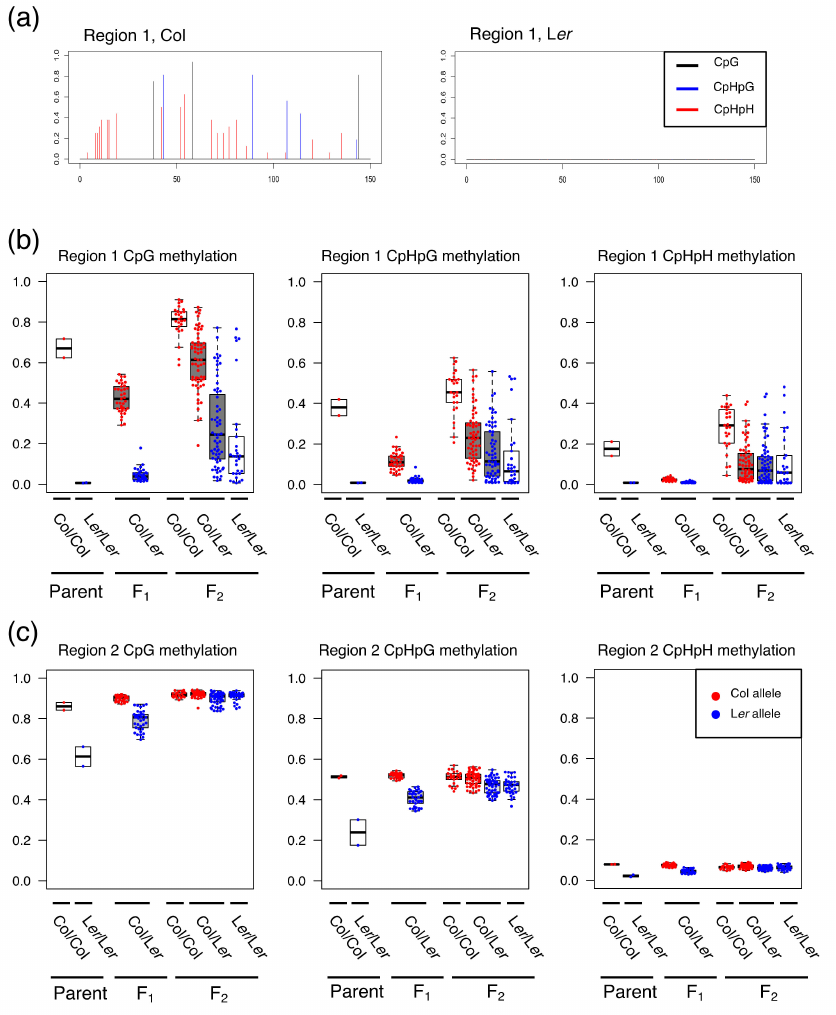
Figure 1. Level of DNA methylations in parents, F 1 , and F 2 . ( a ) Bar plots of DNA methylation level of Col and L er alleles in region 1; ( b , c ) The DNA methylation level of each individual for CpG, CpHpG, and CpHpH is plotted as boxplots and dots for region 1 ( b ) and region 2 ( c ). In each box, the thick line represents the median. Red and blue dots represent the methylation level of the Col and L er alleles,